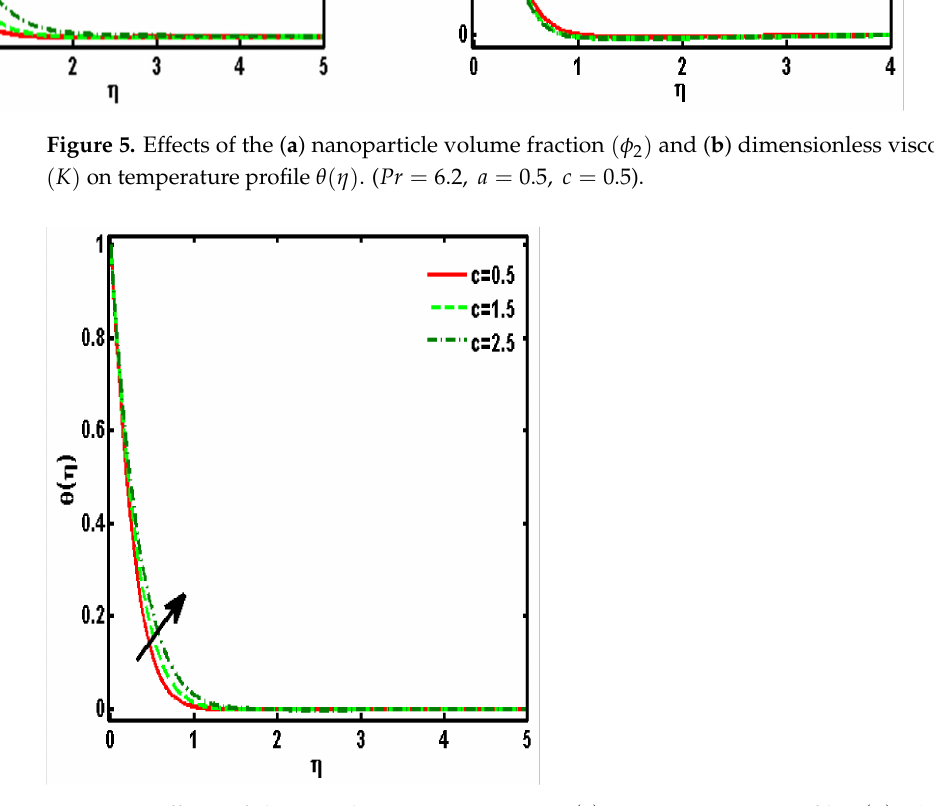
Figure 6. Effects of the stretching ratio parameter ( c ) on temperature profile θ ( η ) . ( φ 2 = 0.01, Pr = 6.2, K = 0.5, a =